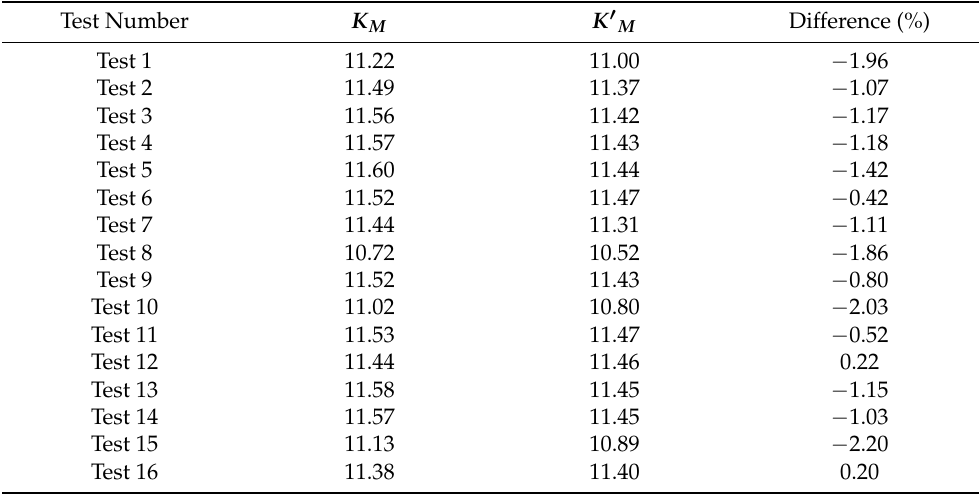
Table 7. Comparison between the moment stiffness coefficients from expressions and finite ele- ment